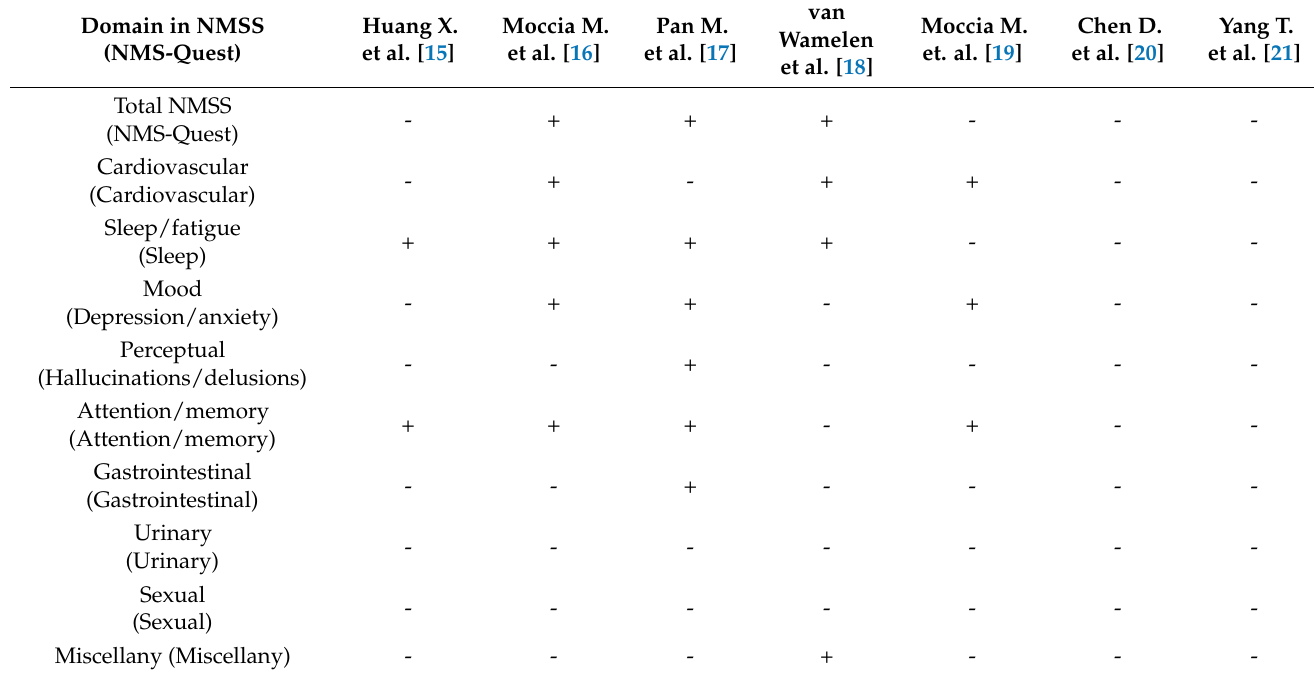
Table 1. Individual domains and connections with uric